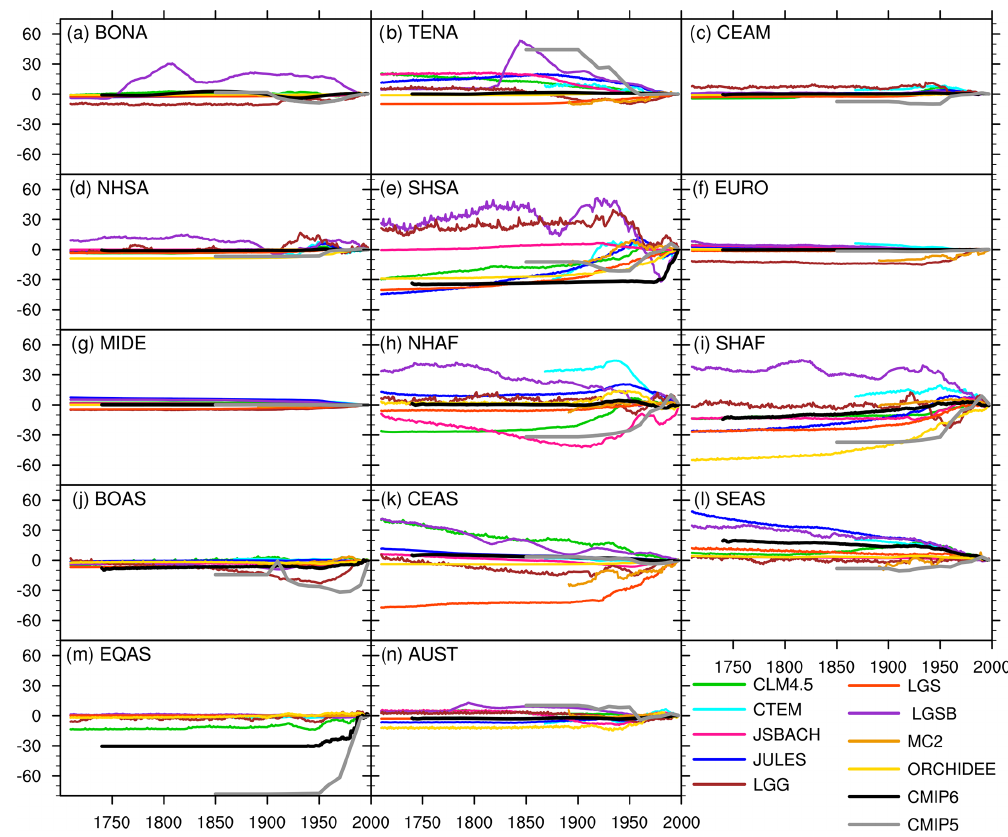
Figure 9. Long-term changes in annual regional fire CO emissions (TgCOyr − 1 ) from FireMIP models and CMIPs. A 21-year running mean is